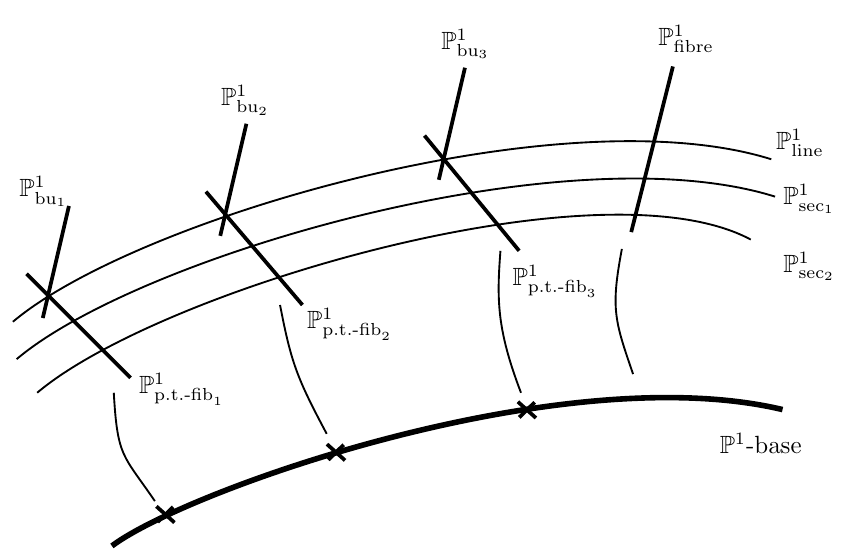
Figure 2 . Schematic drawing of the (cid:12)bration structure of (cid:12)bre surface FS